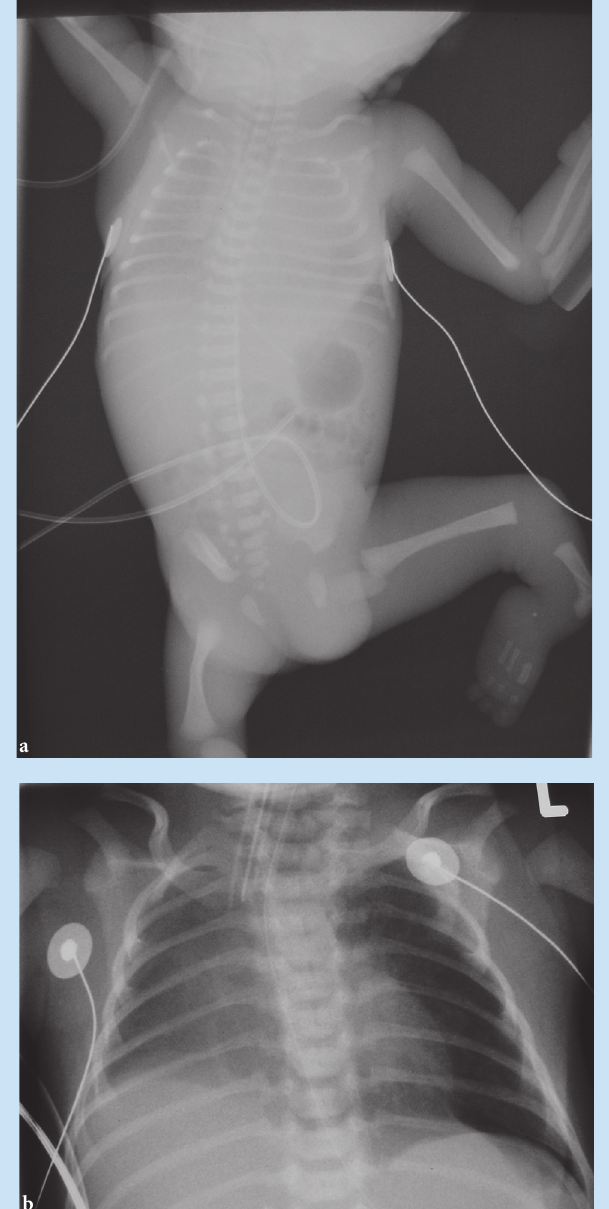
a Figs. 23 (a) - (b). Associations. (a) A patient with pulmonary oedema due to cardiac failure associated with Down’s syndrome also demonstrates the common association of duodenal stenosis with a relatively gasless distal bowel. (b) This patient has cardiomegaly with a visible curvilinear ‘scimitar’ vessel descending to the diaphragm and a smaller right lung. The features are those of partial anomalous venous drainage and pulmonary hypoplasia constituting the scimitar syndrome.